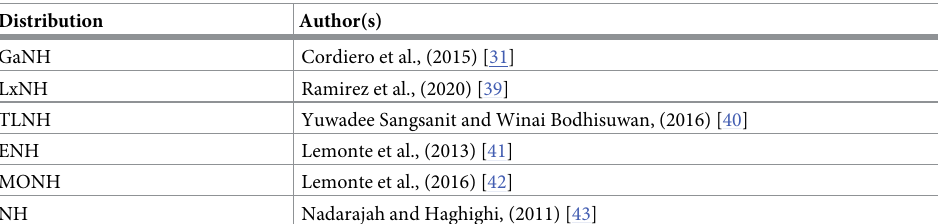
Table 8. The comparative fitted